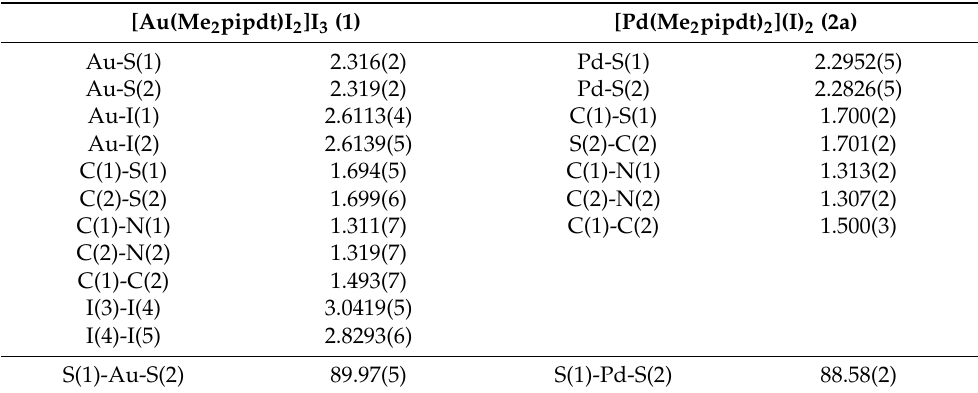
Table 1. Selection of bond distances (Å) and angles ( ◦ ) for compounds [Au(Me 2 pipdt)I 2 ]I 3 ( 1 ) and [Pd(Me 2 pipdt) 2 ](I) 2 ( 2a